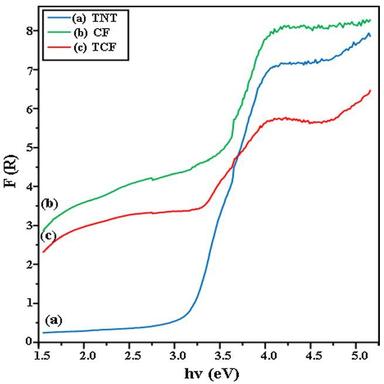
UV–vis diffuse reflectance spectra in Kubelka–Munk units of TNT, CF and TCF materials.